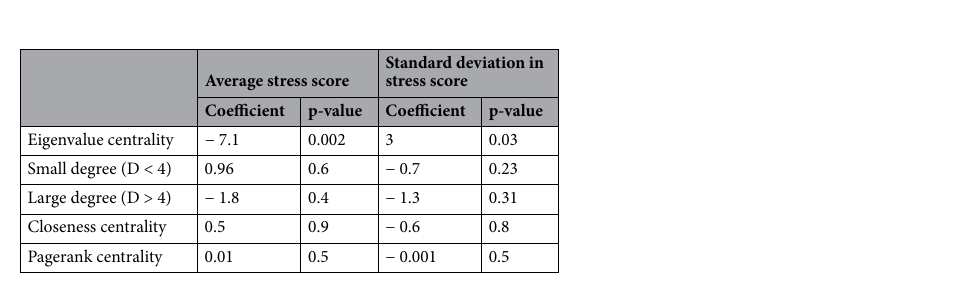
Table 3. GEE results with true stress score as dependent variable and graph centrality metrics as independent